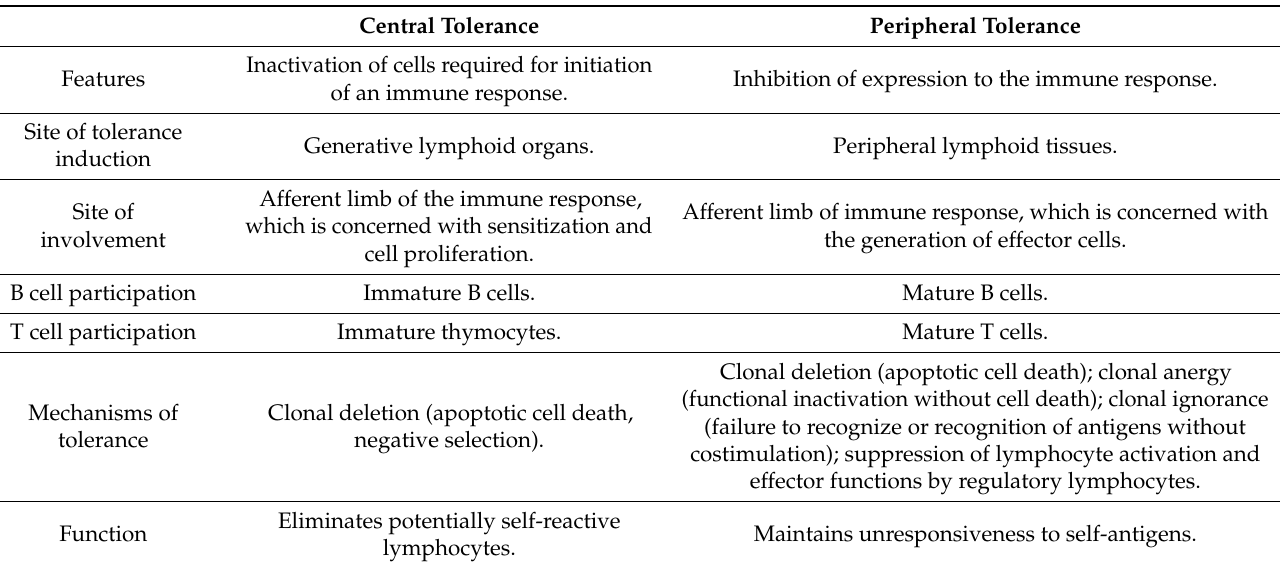
Table 2. Central and peripheral immunologic